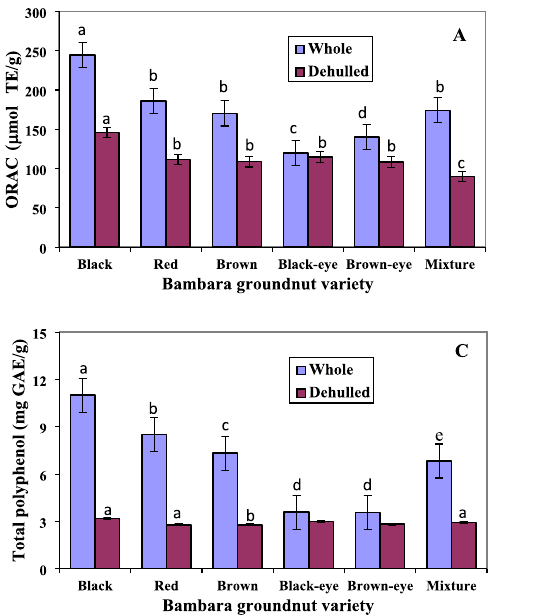
Figure 1. Antioxidant properties and total phenolic content of Bambara groundnut seed extracts. ( A ) Oxygen radical absorbance capacity ( ORAC; µmol TE/g); ( B ) ferric reducing antioxidant property (FRAP; μmol AAE/g); and ( C ) total polyphenol content (mg GAE/g) of different varieties of whole and dehulled Bambara groundnut. Data represent the mean ± standard deviation of triplicate readings. Different alphabets within each form (whole or dehulled) differ significantly (p <